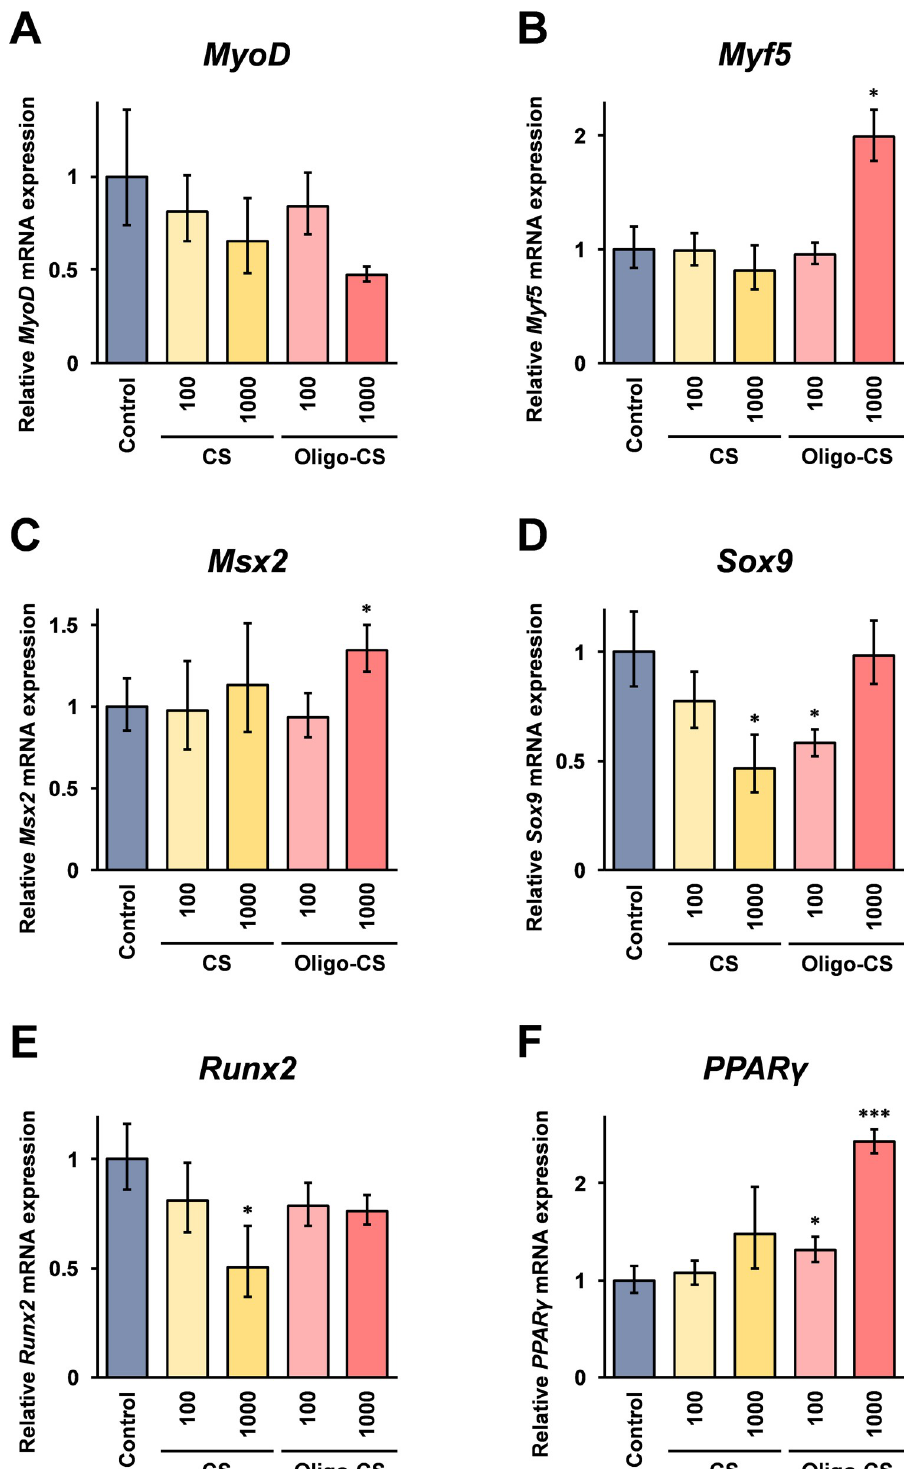
Fig 5. The effects of CS and Oligo-CS on mRNA expression of marker genes. C2C12 cells were grown in differentiation medium containing the indicated concentrations of CS or Oligo-CS for 72 hours. Then, the cells were harvested, and the total RNA isolated from the cells was subjected to real-time RT-PCR analysis using the specific primer set for each of the genes. The data indicate relative expressions compared to untreated control cells after